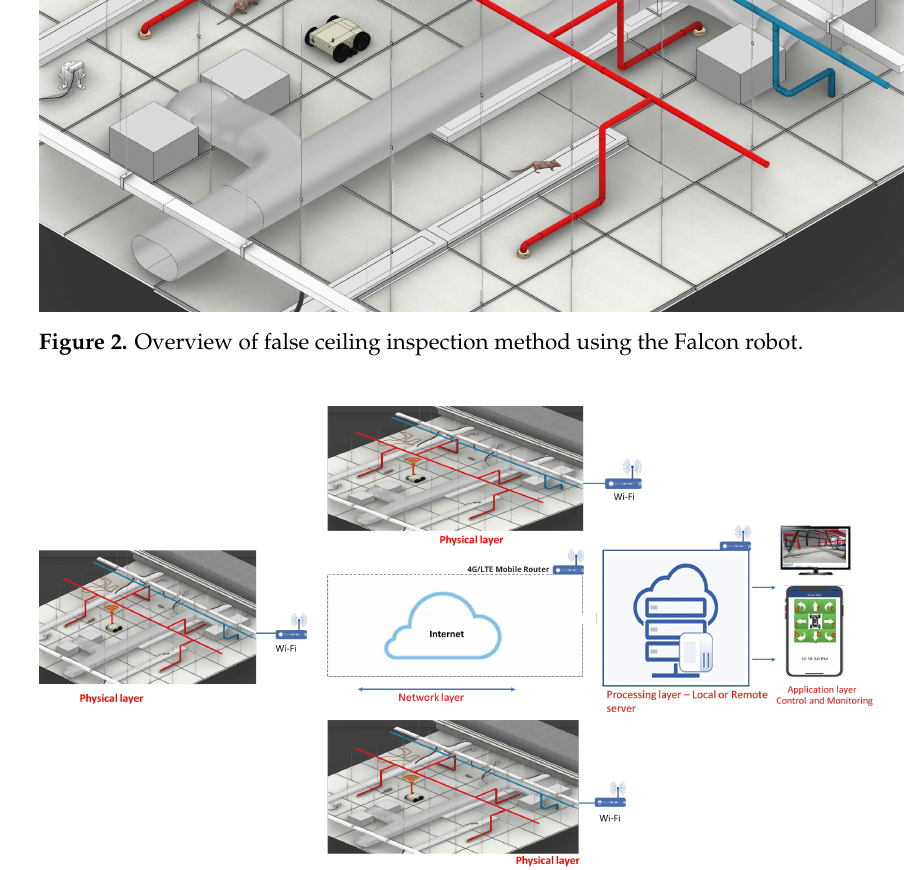
Figure 3. IoRT framework for rodent inspection in a false